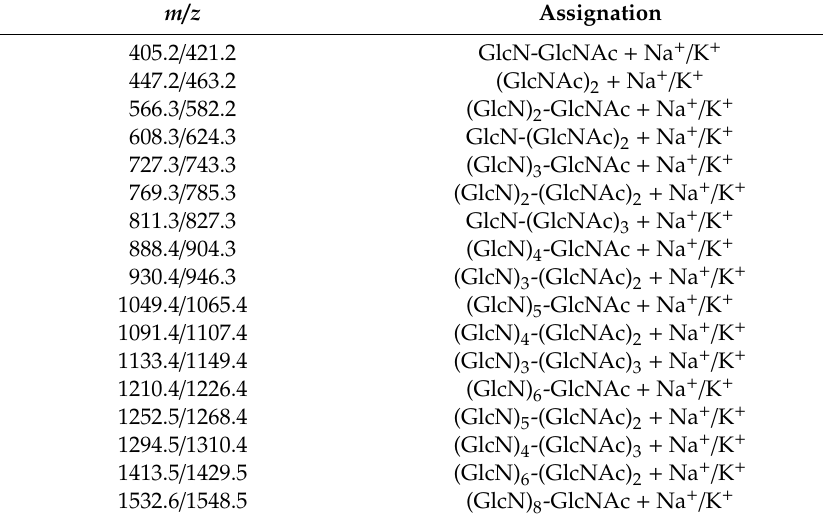
Table 3. Main identified signals in the MALDI-TOF mass spectrum of the reaction between chitosan QS1 and chitinase Chit42. Reaction conditions were as described in Figure